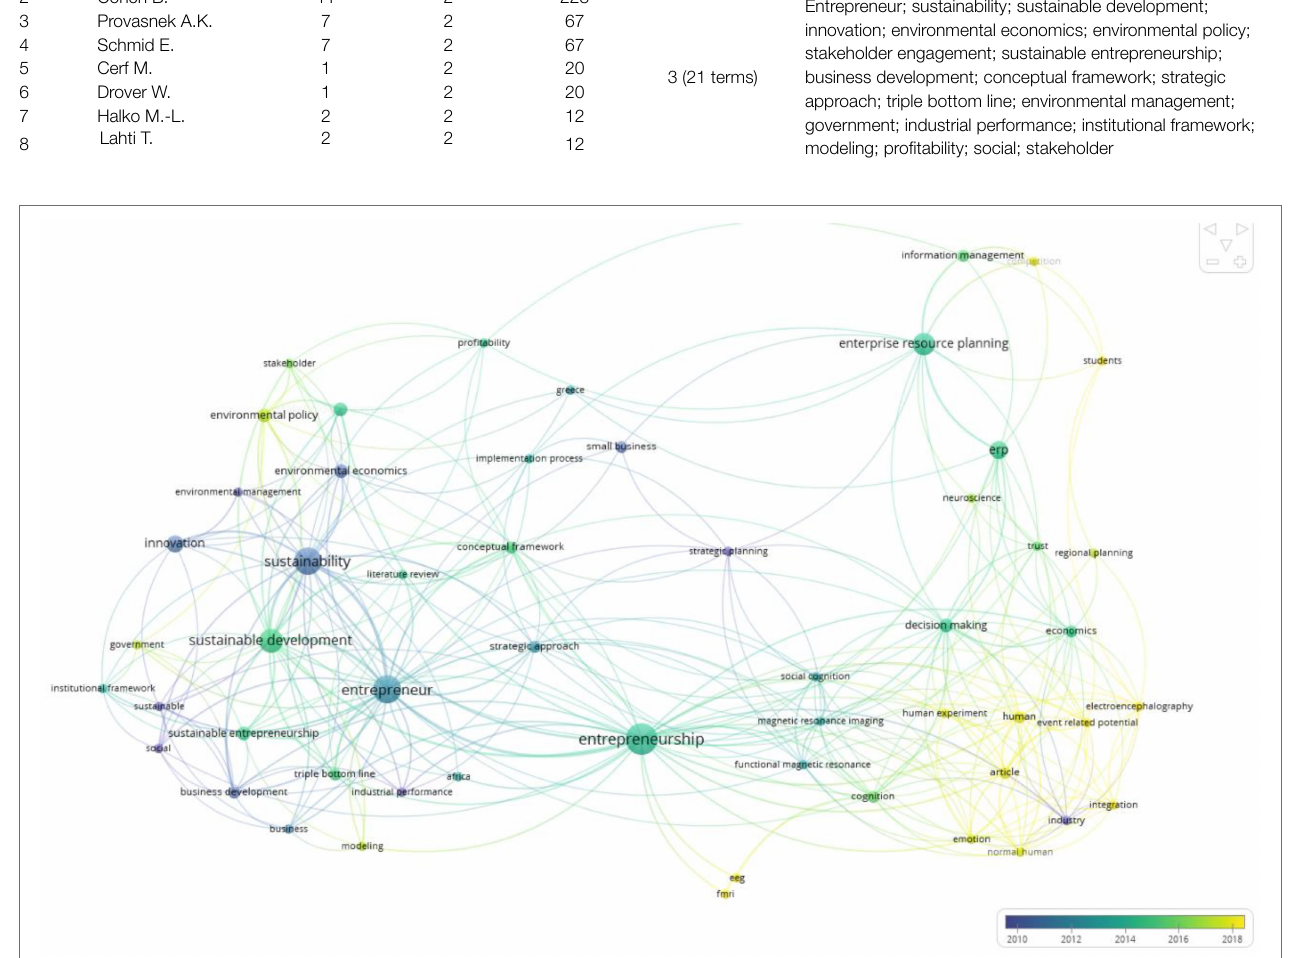
FIGURE 7 | Keyword evolution analysis.